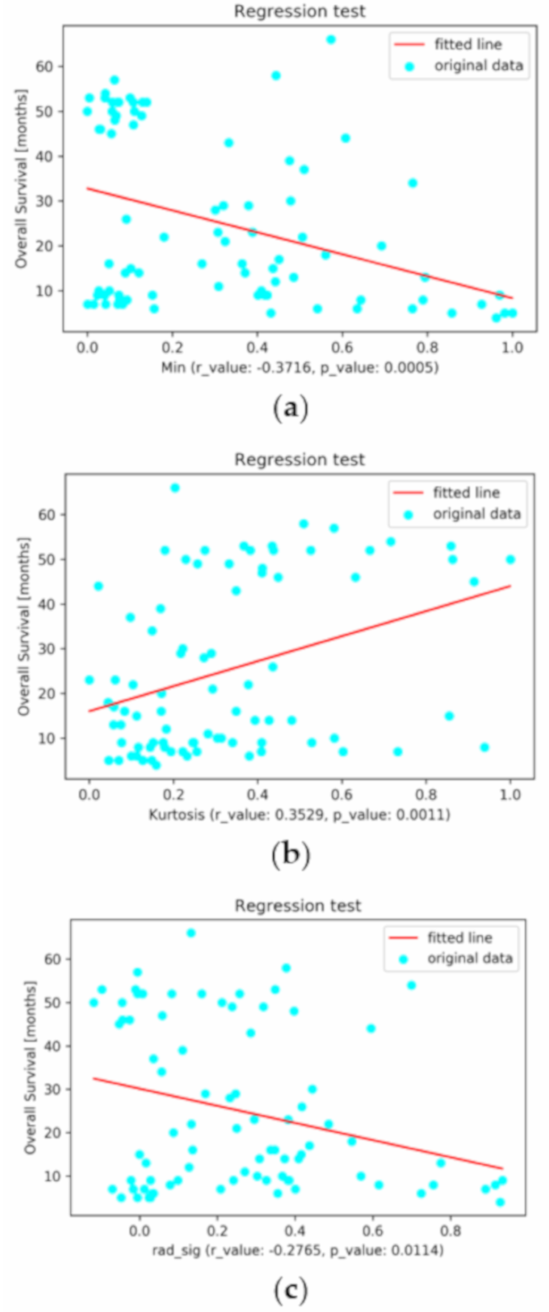
Figure 2. The linear regression diagrams for overall survival (in months) based on ( a ) SUV Min , ( b ) kurtosis, and ( c ) radiomics